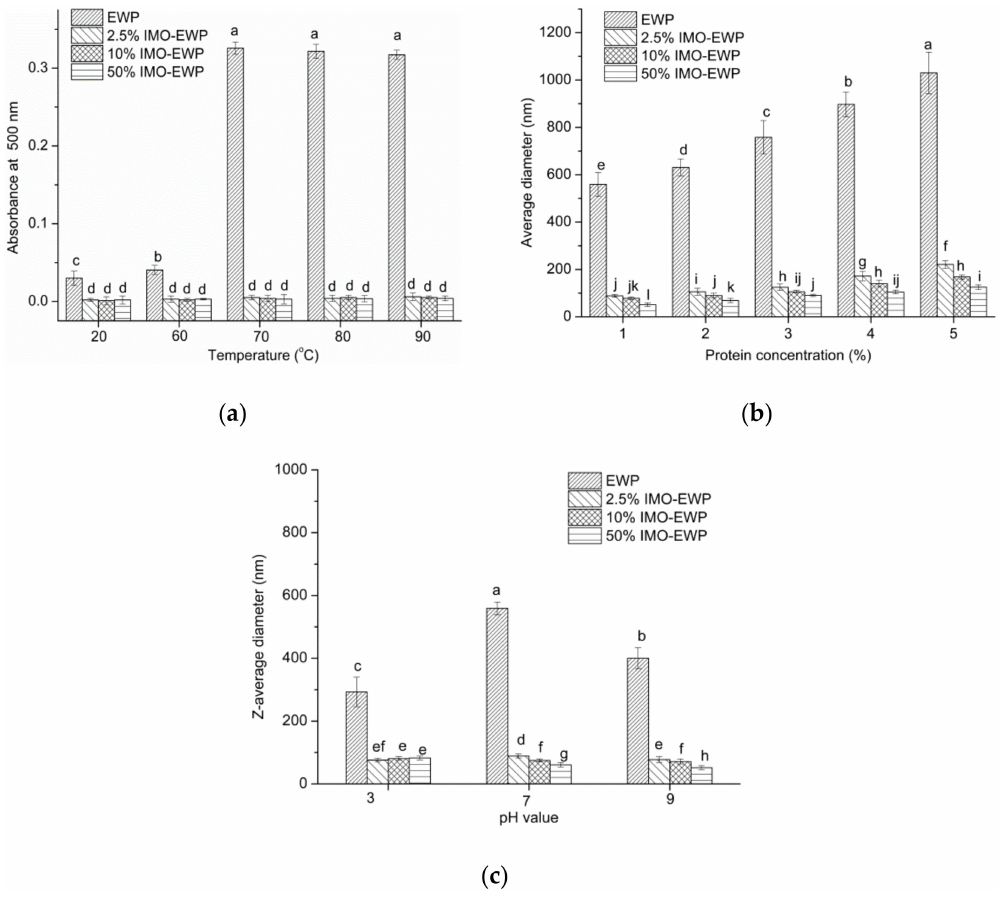
Figure 5. Turbidity of the heat-induced particles formed from EWP and IMO-EWP conjugates at different temperatures ( a ). Z-average hydrodynamic diameters of heat-induced particles formed at different protein concentrations ( b ) and pHs ( c ) from EWPs and conjugates. Different letters (a–l) indicate significant differences ( p <